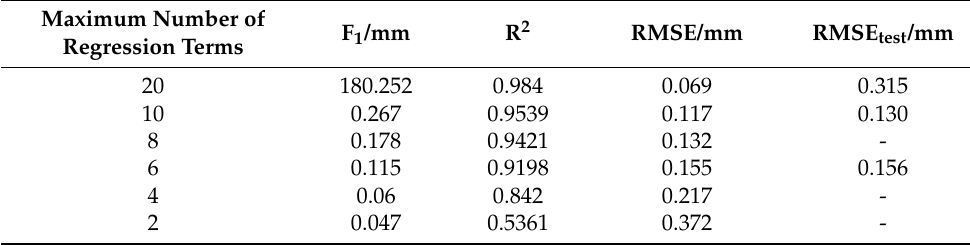
Table 10. Maximum error effect, coefficient of determination, and standard error in dependence of the maximum number of regression terms for regression analysis of carburization depth.